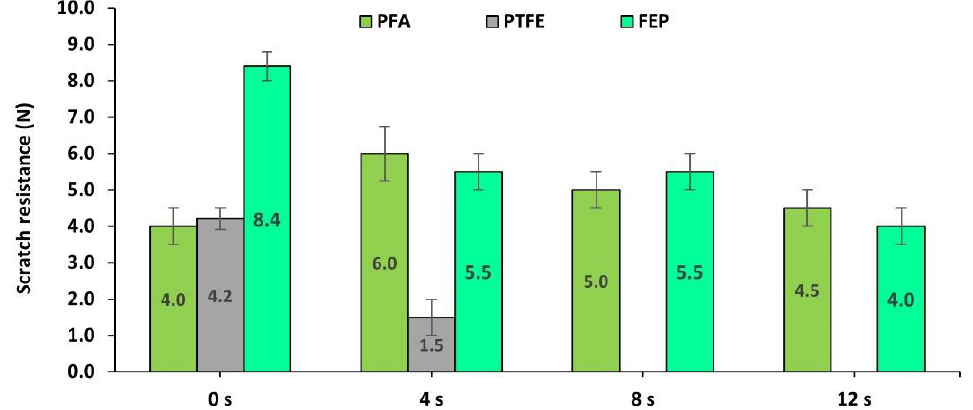
Figure 13. Evolution of the scratch resistance (N) shown by PFA, PTFE, and FEP after 0, 4, 8, and 12 s wear processes via the projection of plastic-polymer particles at 0.4 MPa.